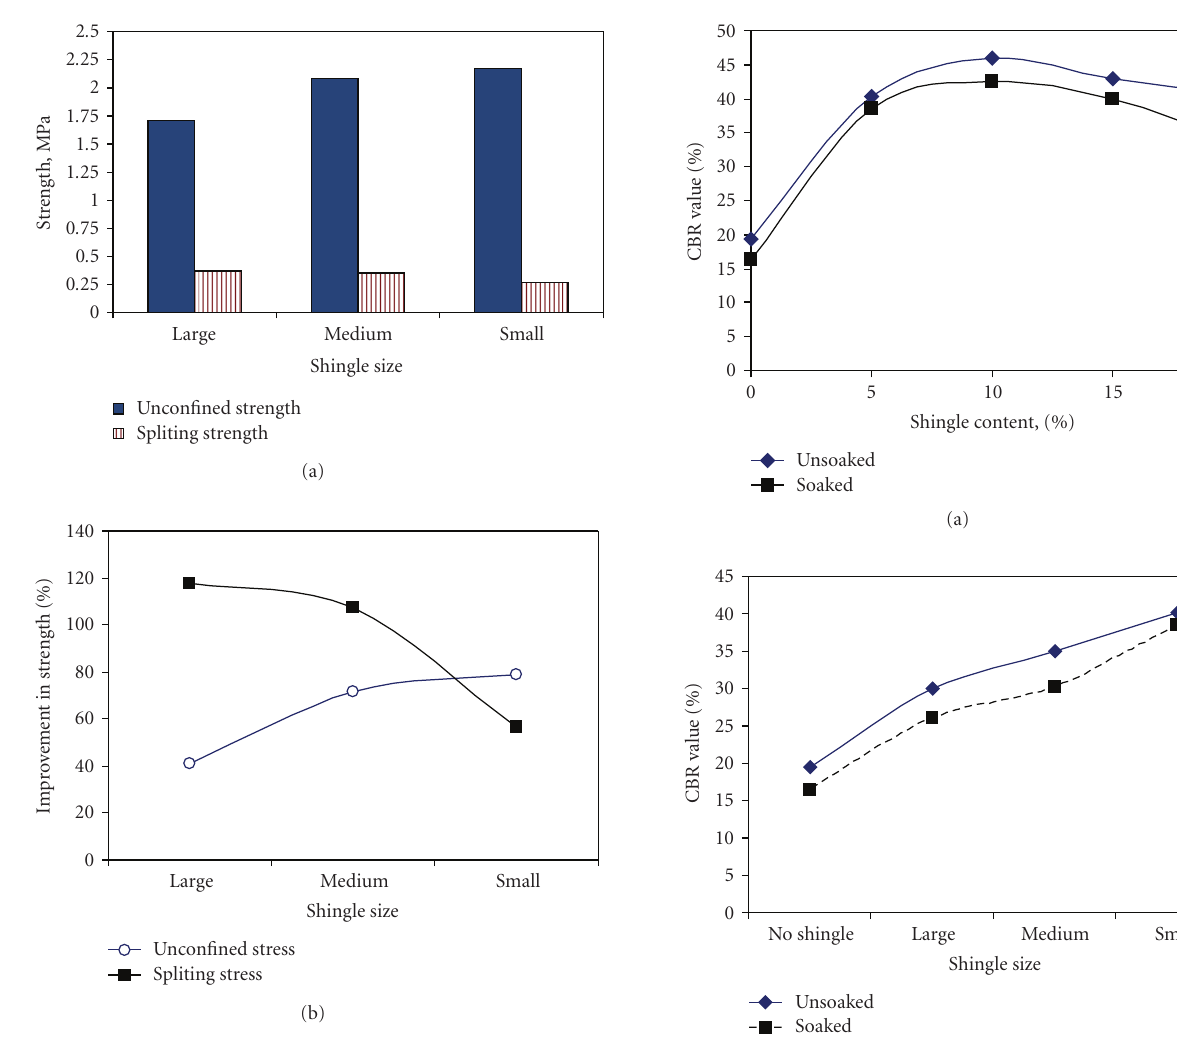
Figure 4: E ff ect of shingle size on compressive and tensile strengths: (a) di ff erent shingle sizes (with 10% CKD2) and (b) Percentage improvement. Figure 5: CBR results: (a) di